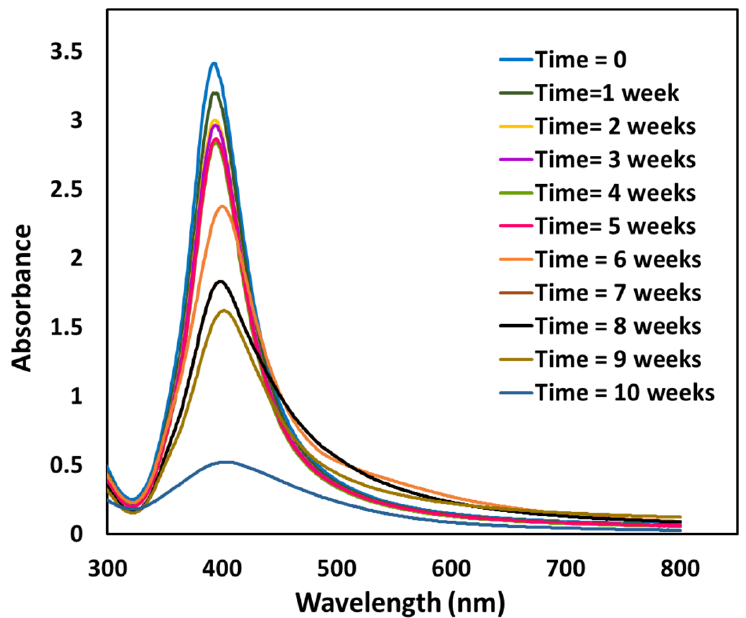
Figure 2. UV-Vis spectra of colloidal AgNPs over a period of 10 weeks. The peaks of absorption were at a wavelength of 379 nm and 406 nm at the initial time (time = 0) and after 10 weeks, respectively. With more time passing, the dispersed silver nanoparticles’ sizes seemed to grow larger (bigger red shift noted after 10 weeks).